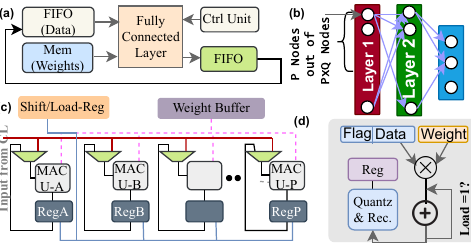
Figure 9. ( a ) Block diagram of the fully connected layer (FcNN) ( b ) An example of FcNN in any learning model ( c ) Functional diagram of the FcNN ( d ) MAC unit in the FcNN.